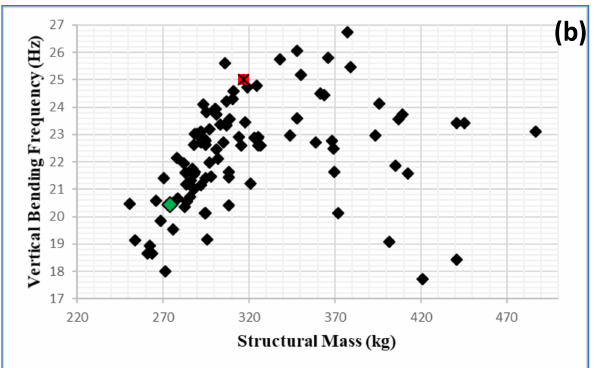
Figure 16. ( a ) Vertical bending frequency vs. structural mass for all designs analyzed and ( b ) violation vs. structural mass for all designs analyzed during optimization.